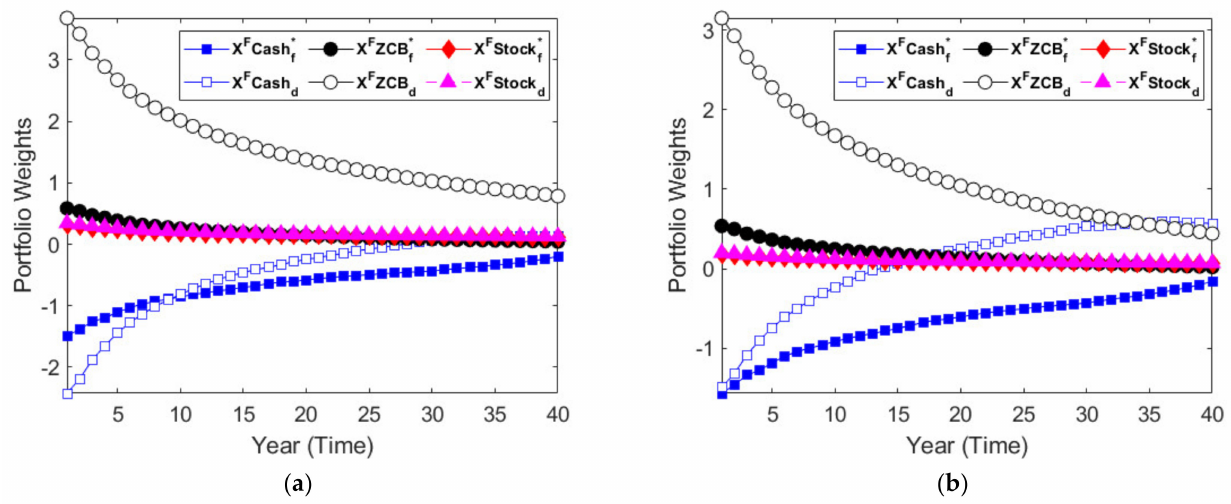
Figure 2. Optimal asset allocation with a high exchange rate risk. Notes: The ( a , b ) depict the optimal allocation weights of the pension fund portfolio ( F ) among cash, zero-coupon bonds (ZCBs), and stocks as being the case of suffering the higher exchange rate risk σ X = 0.2, compared with those in Figure 1,